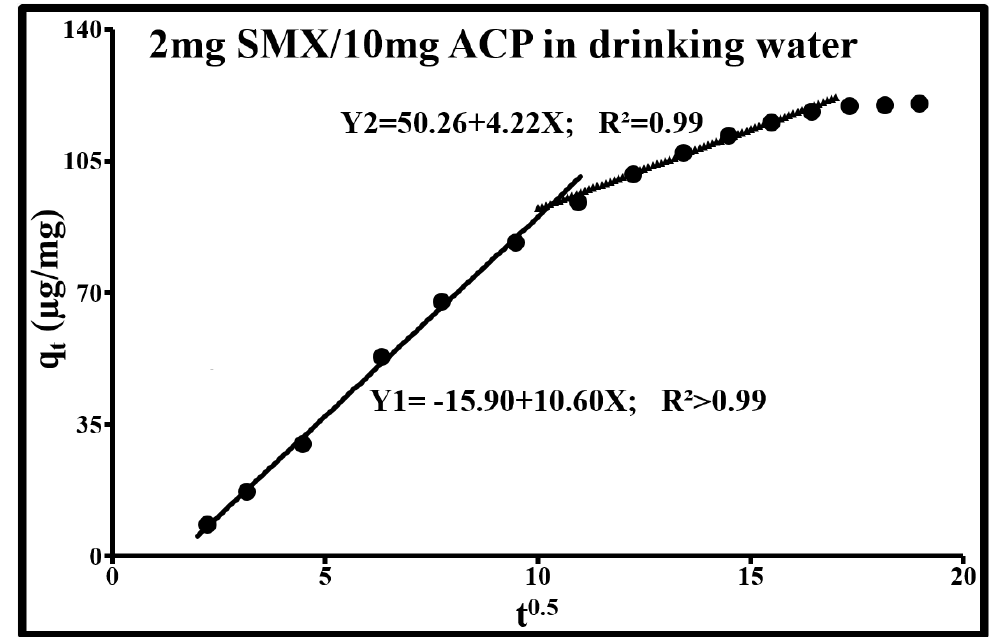
Figure 6. Weber–Morris plots for the sorption of SMX by ACP Norit SA Super in drinking water. (SMX: 2mg/L; ACP: 10 mg/L; pH = 8.1, T = 293 K).